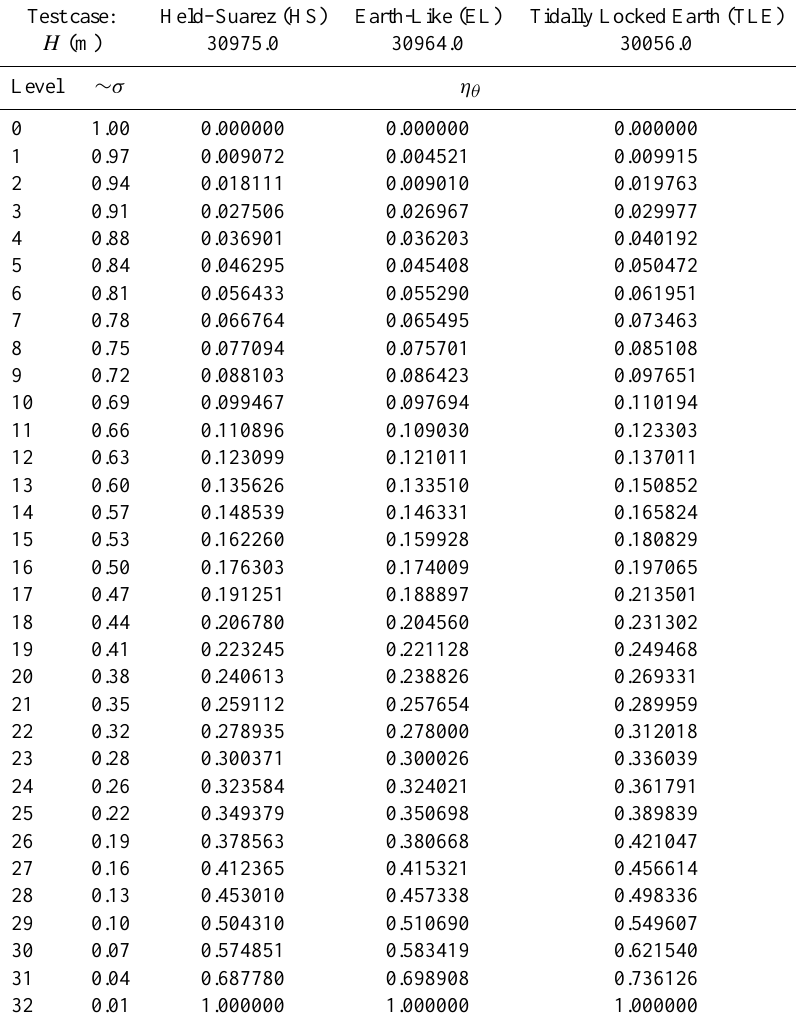
Table A1. Table showing the dimensionless vertical coordinate for the θ levels of the three model set-ups, η θ ( η = z/H ) alongside the approximate σ levels and the model domain height ( H